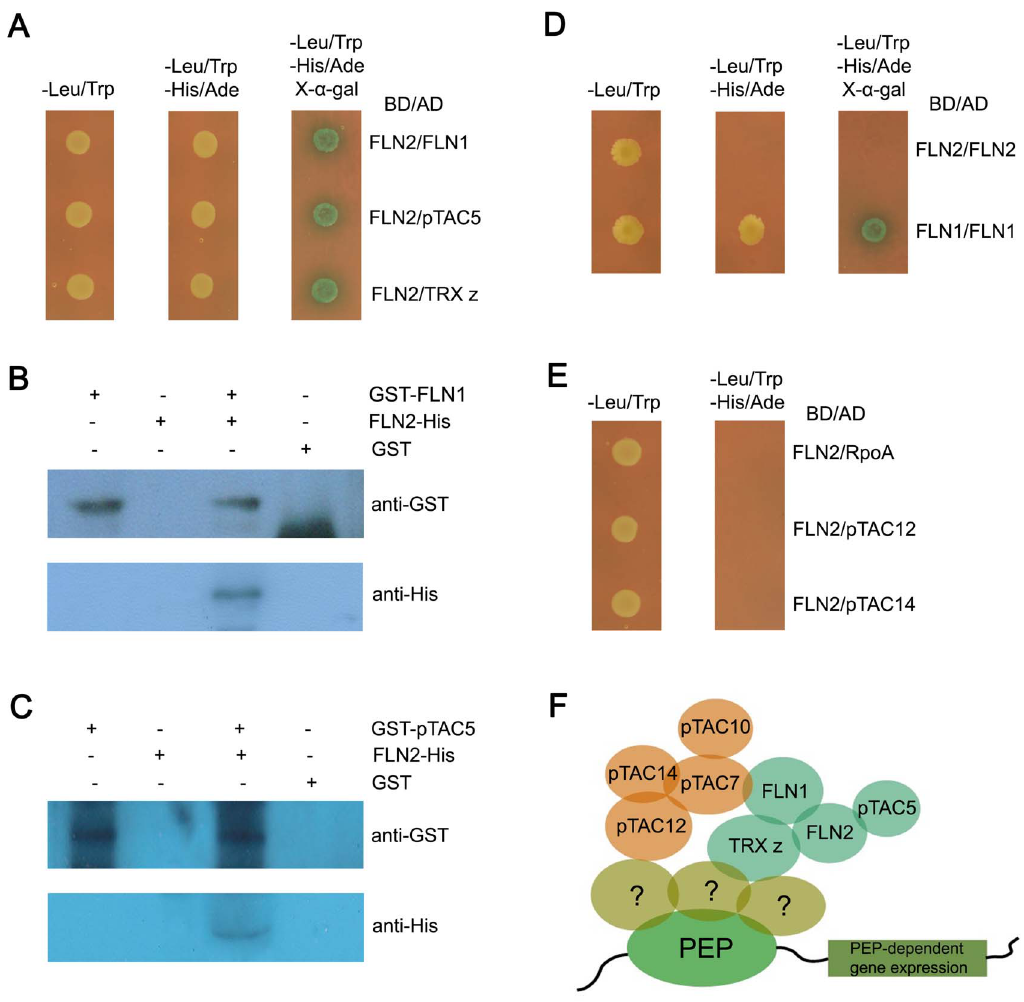
Figure 3. The relationships between FLN2 and other components of TAC. (A) Interactions of FLN2 with FLN1, pTAC5 and TRX z proteins in yeast. (B) GST pull-down assay revealed the existence of a physical interaction between FLN2 and its homologous protein FLN1. (C) In vitro GST pull- down assay for interaction between FLN2 and pTAC5. (D) FLN1 can interact with itself in yeast, while FLN2 can not. (E) Non-interaction existed between FLN2 and three essential subunits of TAC complex including RpoA, pTAC12 and pTAC14. (F) The primary working model for TRX z, FLN1, FLN2, pTAC5, pTAC7, pTAC10, pTAC12 and pTAC14.